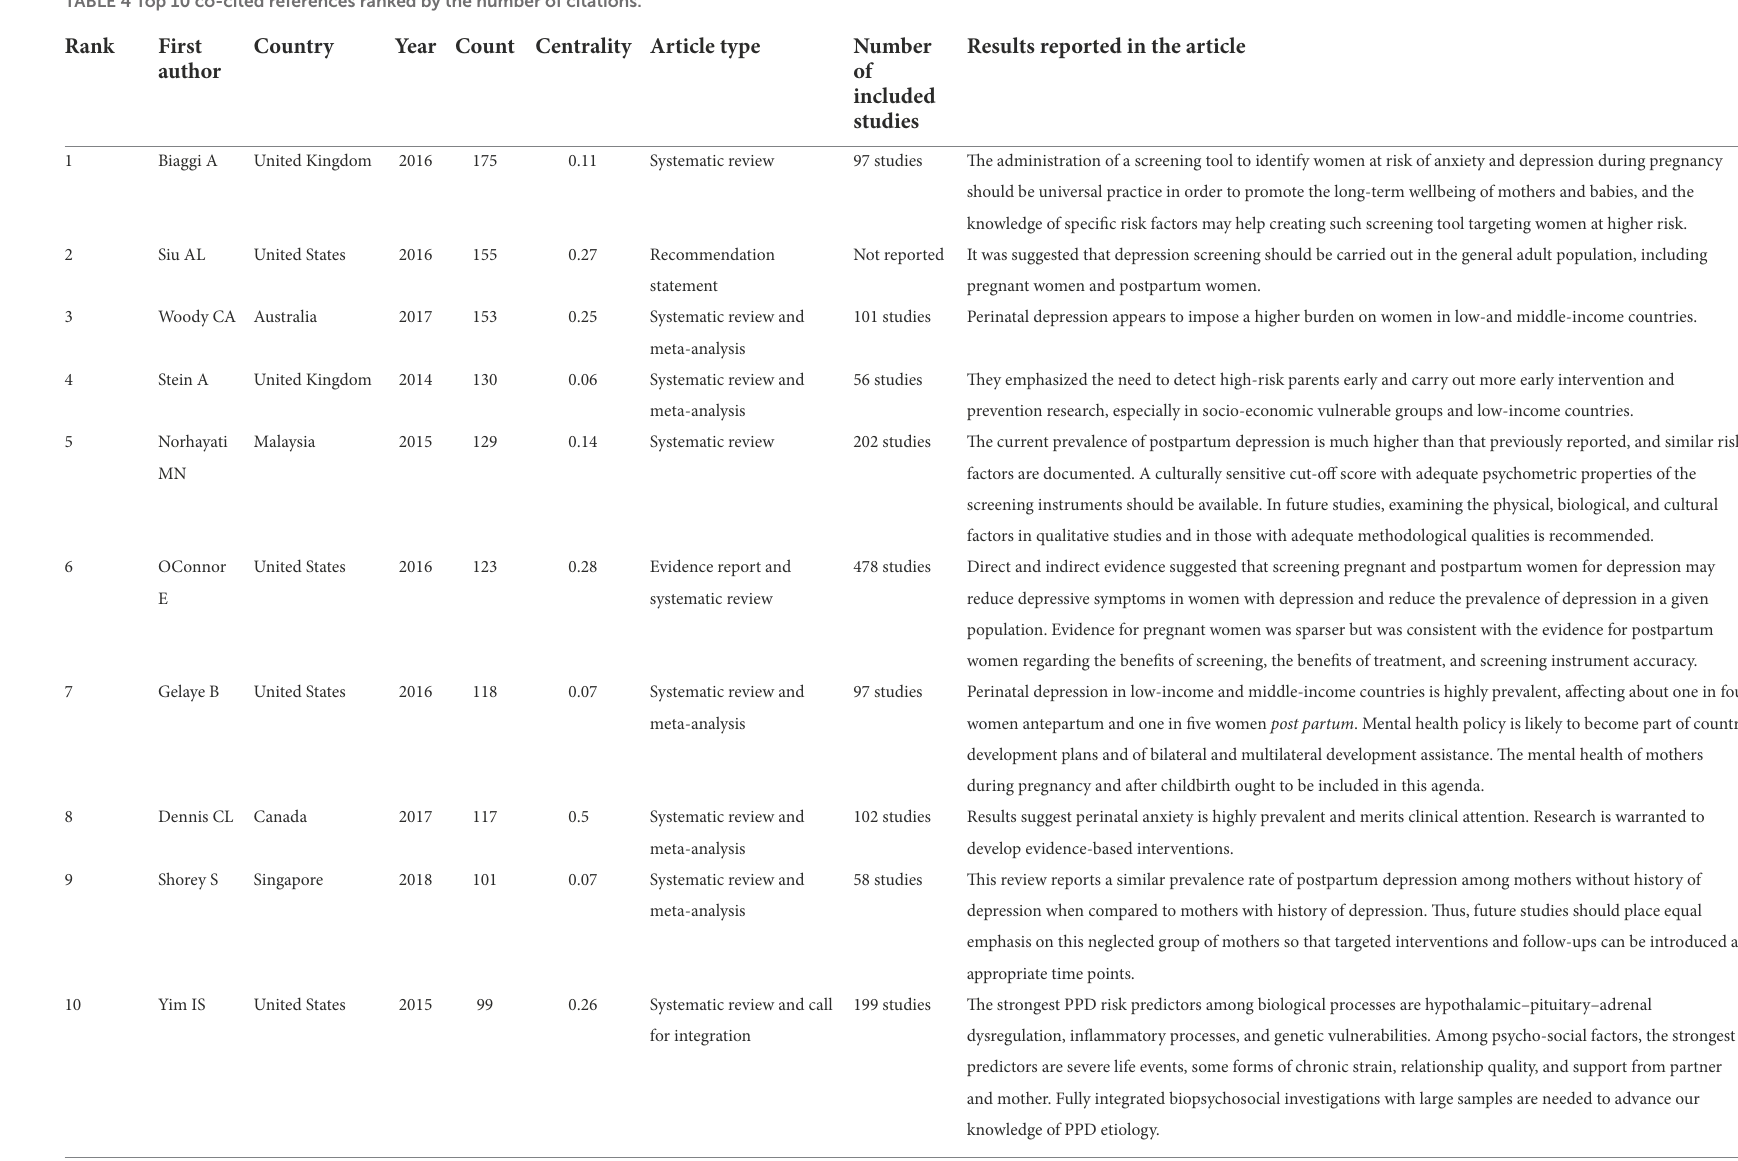
TABLE 4 Top 10 co-cited references ranked by the number of